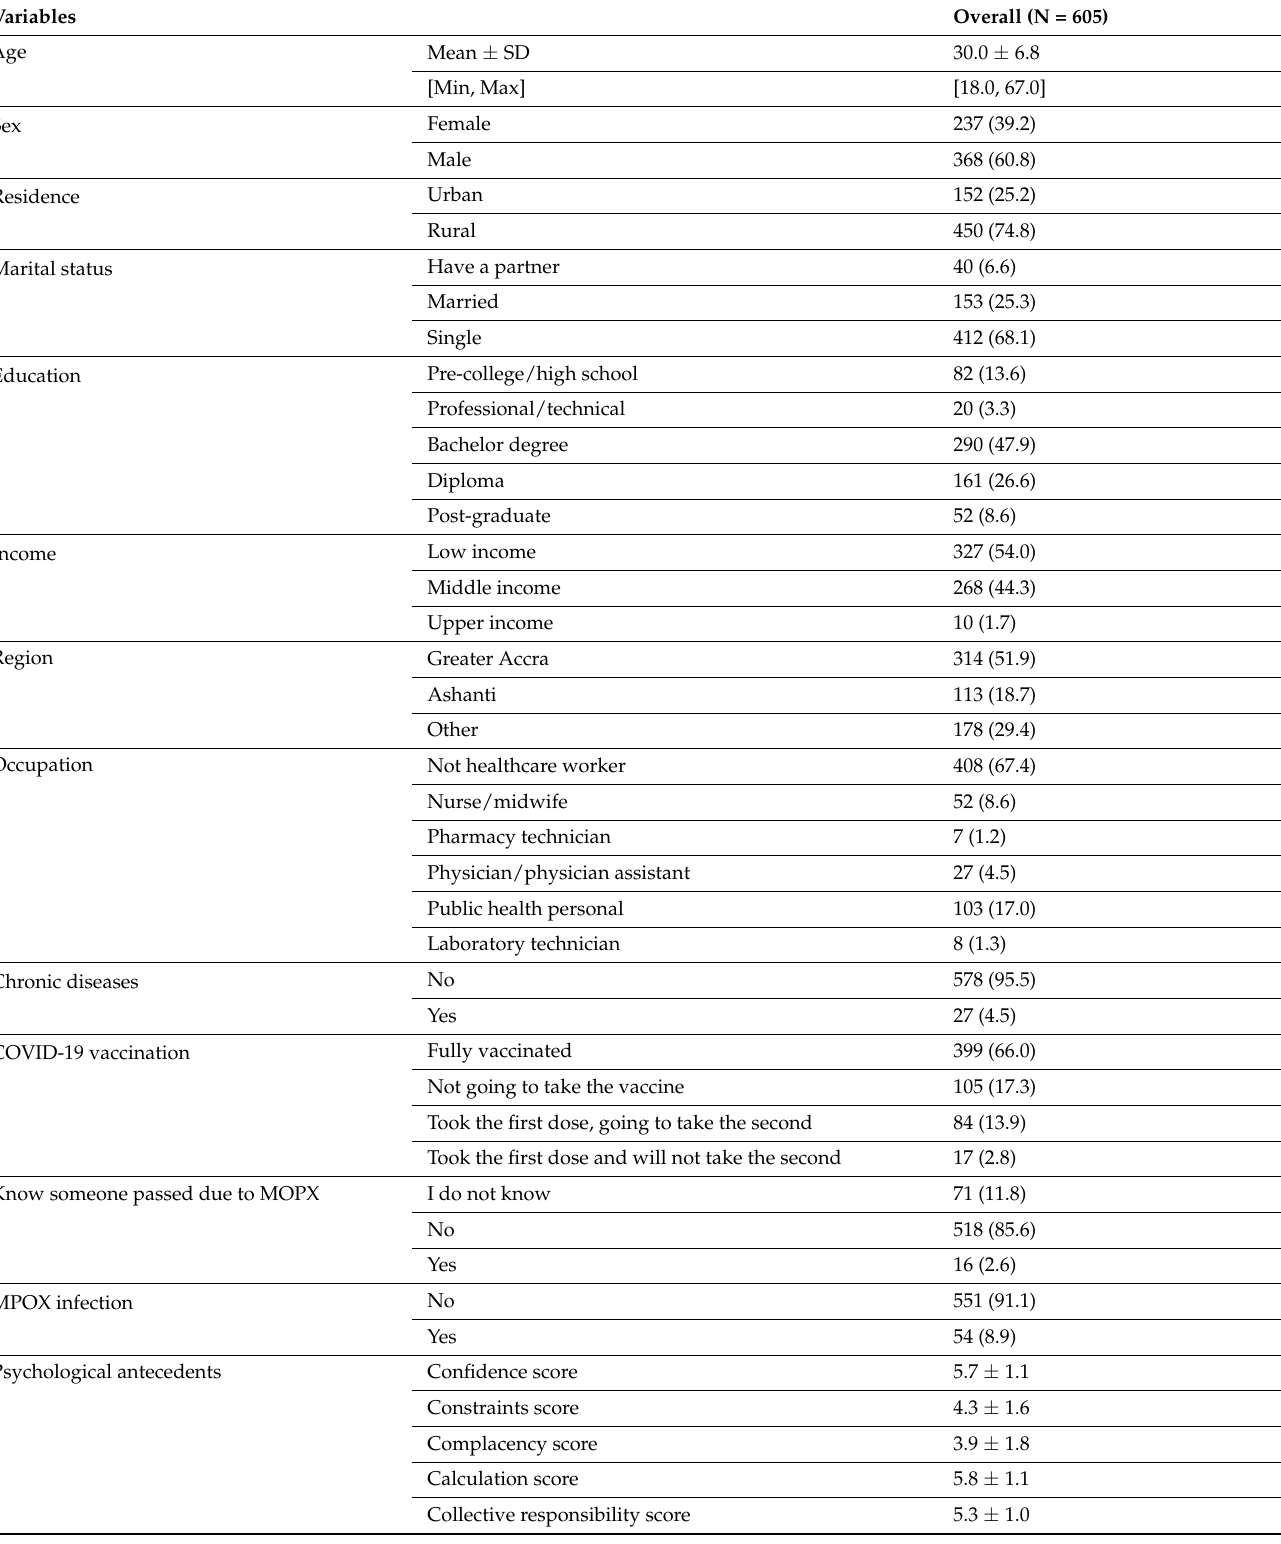
Table 1. Sociodemographic criteria of the studied population of